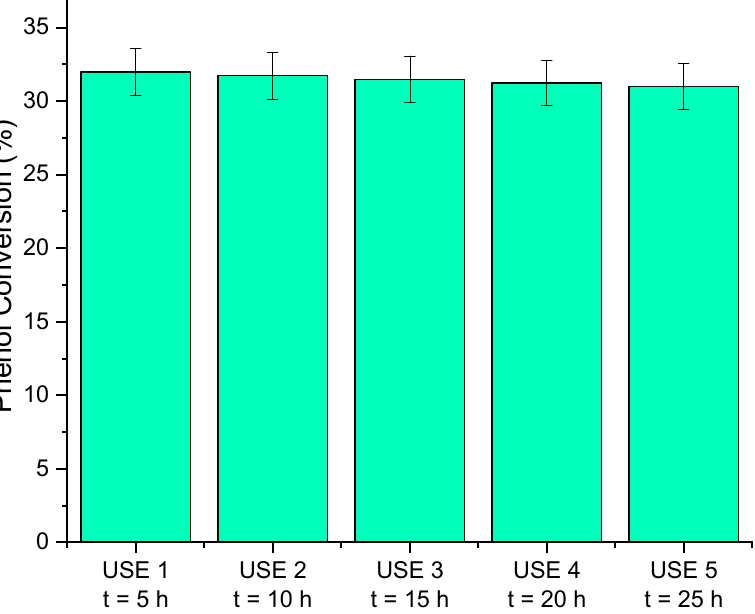
Figure 11. Reusability experiments results, fixing T = 40 ◦ C, an initial phenol concentration of 25 ppm, and a catalyst loading of 0.125 g/L.